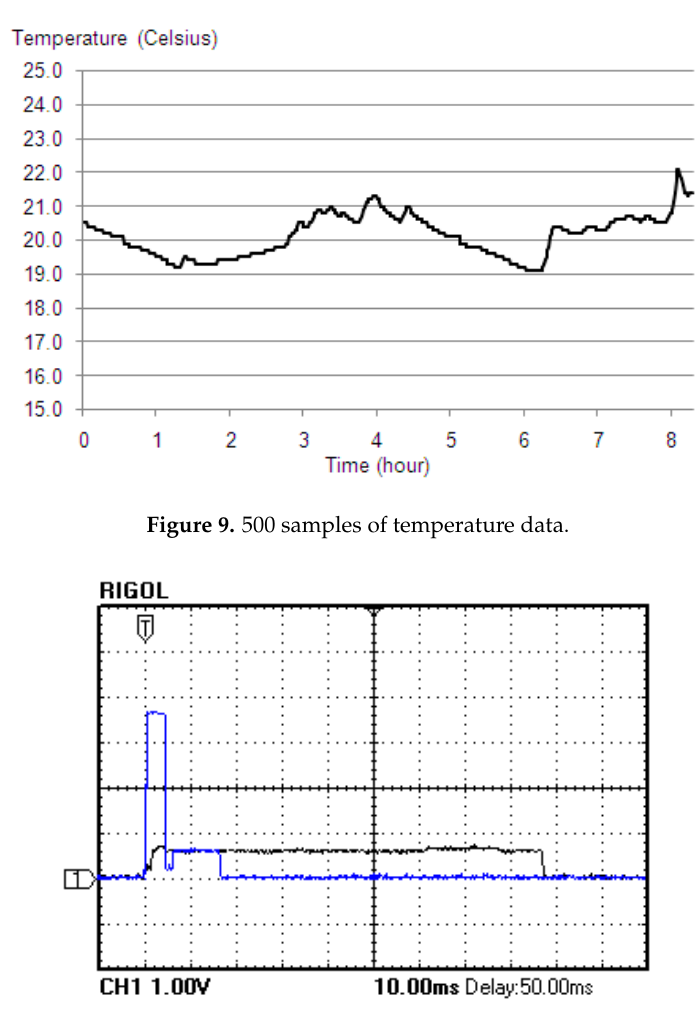
Figure 10. Current consumption of Lempel–Ziv–Oberhumer (LZO) compression of 500 temperature samples with a fixed frequency (black) and switched frequency (blue).